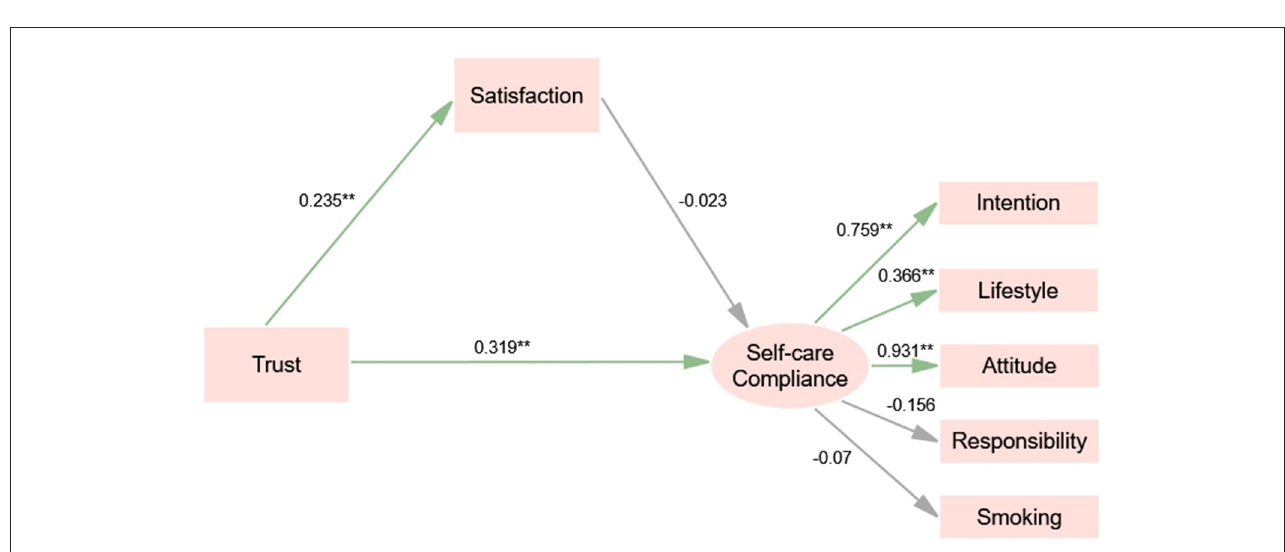
FIGURE4 Structural equation model of trust, satisfaction and compliance (sub-sample: female). Significant codes: ** P < 0.01; * P <